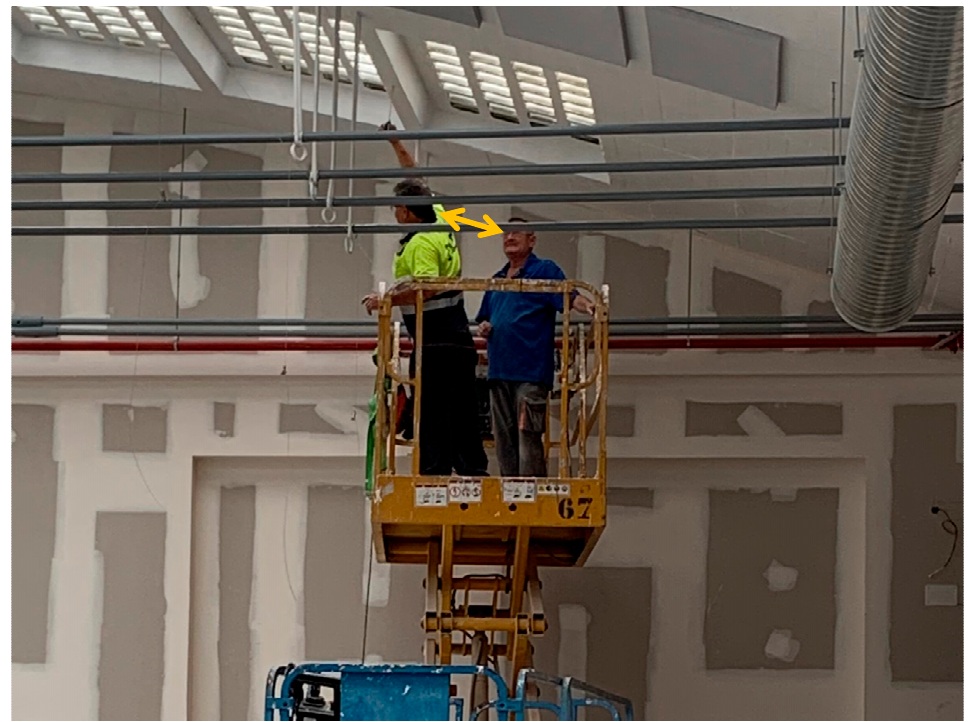
Figure 4. Workers installing false ceiling supports on a lifting platform. The photograph marks the distance between the workers, which is lower than 1.00 m (author’s photograph).